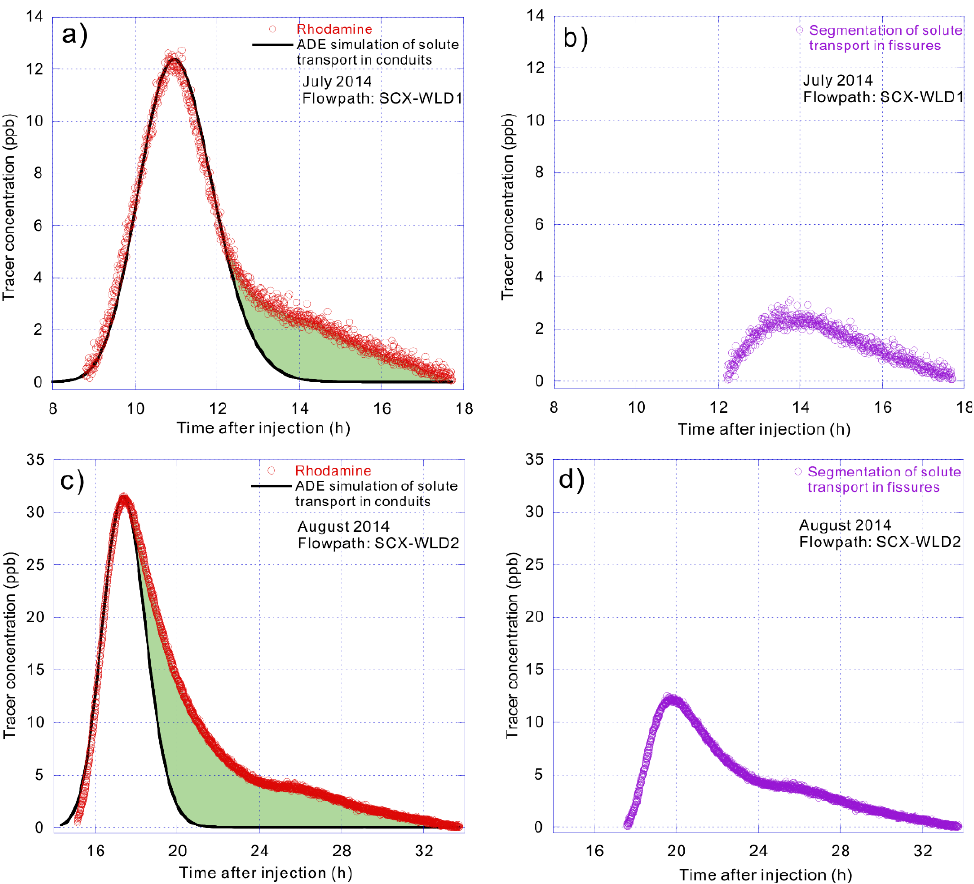
Figure 5. Breakthrough curves, fitting curves of solute transport in conduit flow and segmentations of solute transport in fissure flow of SCX – WLD (Shicaoxi-Wulongdong). ( a ) Breakthrough curve of SCX – WLD and the fitting curve of solute transport in conduit flow using advection – dispersion equation on 12 July 2014. ( b ) Segmentation of solute transport in fissure flow that refers to the solute storage and release in the dynamic pathway of SCX – WLD on 12 July 2014 . ( c ) Breakthrough curve of SCX – WLD and the fitting curve of solute transport in conduit flow using advection – dispersion equation on 12 August 2014. ( d ) Segmentation of solute transport in fissure flow that refers to the solute storage and release in the dynamic pathway of SCX – WLD on 12 August 2014 .